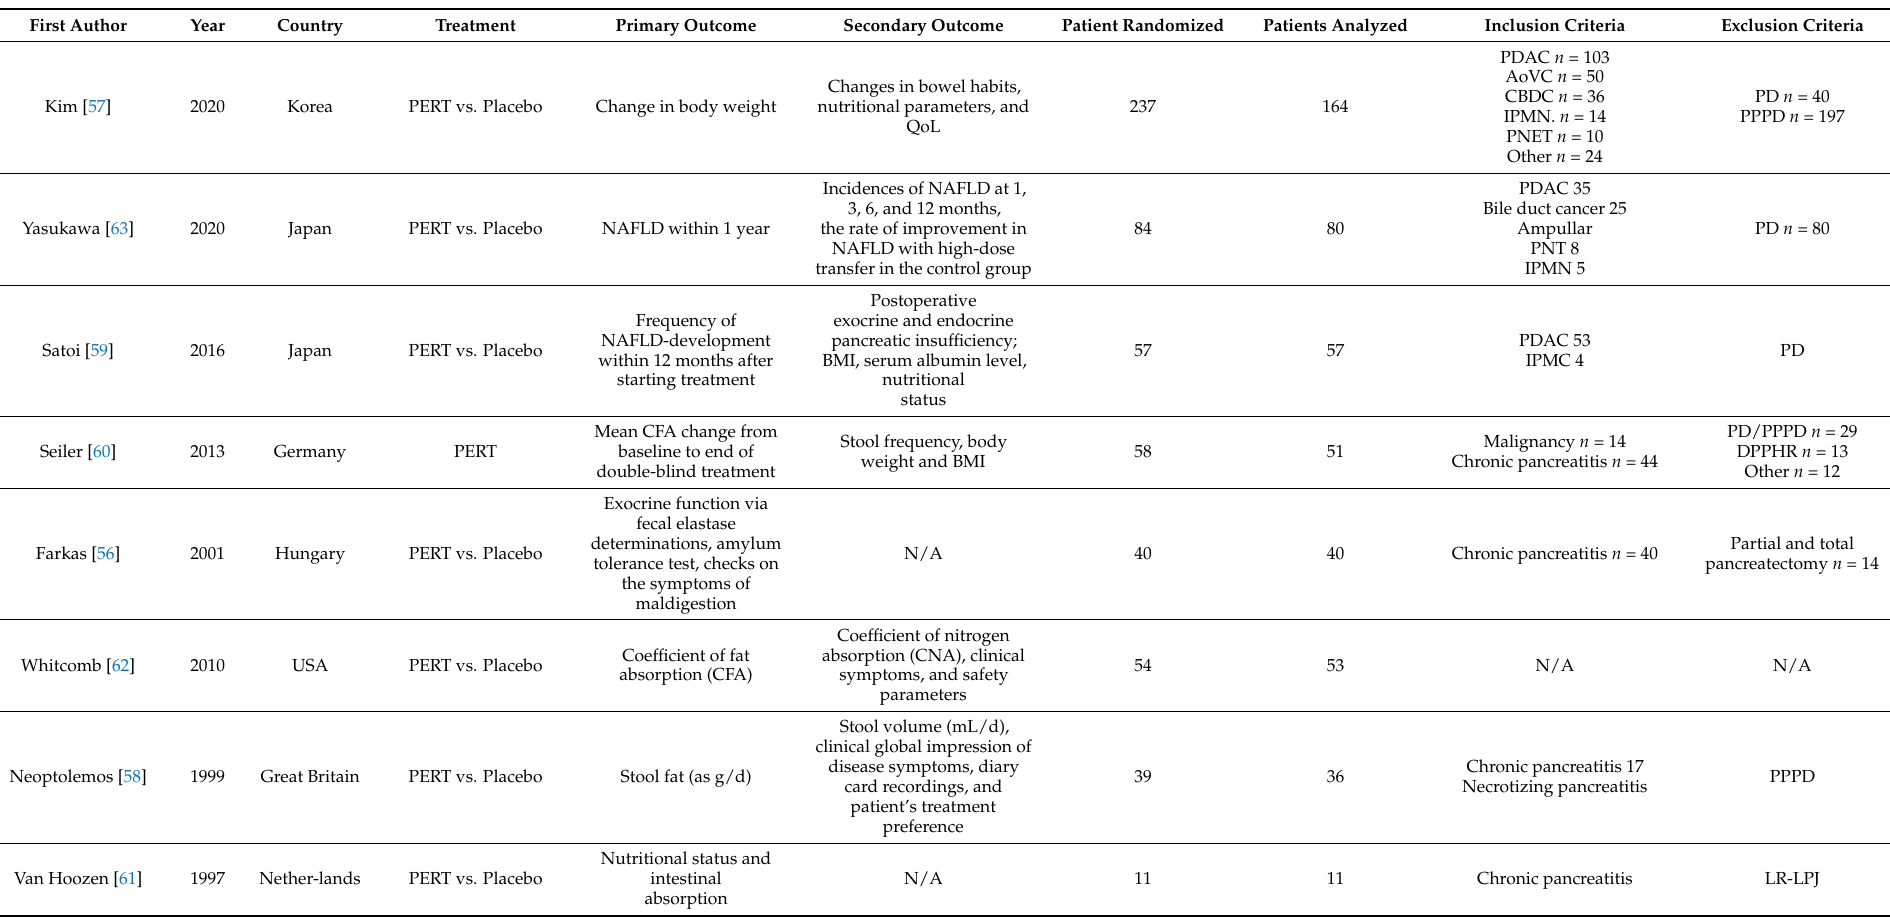
Table 6. Pancreatic Enzyme Replacement